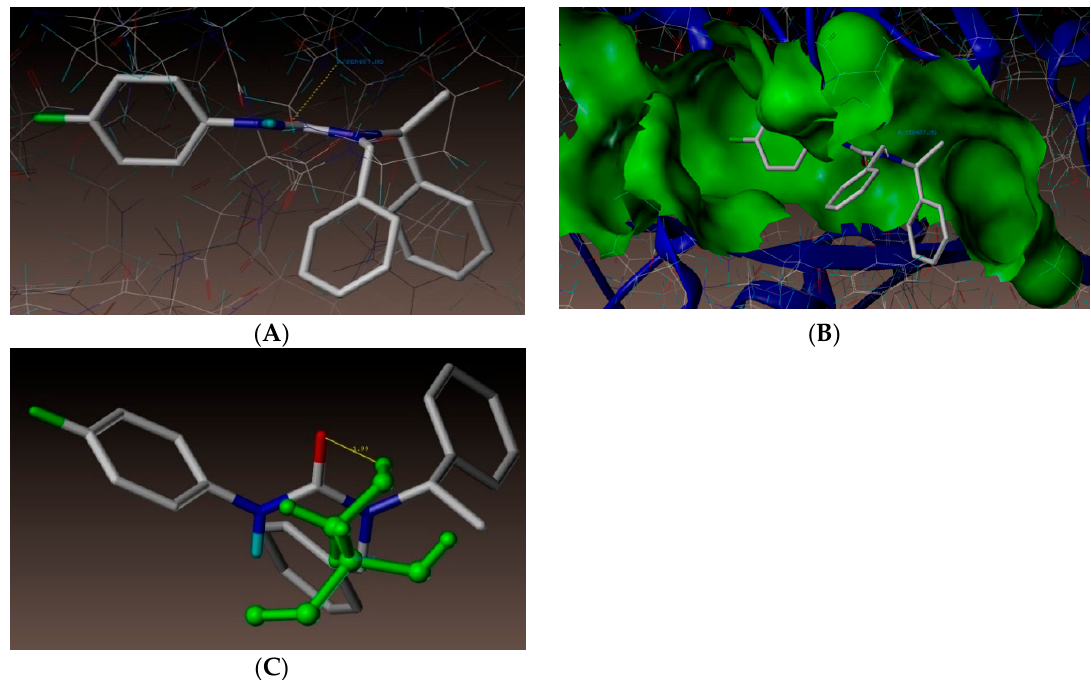
Figure 3. ( A ) Docked view of compound 3n . ( B ) Docked view of compound 3n at the active site of enzyme PDB ID: 3UDI. ( C ) Hydrogen-bond interaction of compound 3n at the active site.